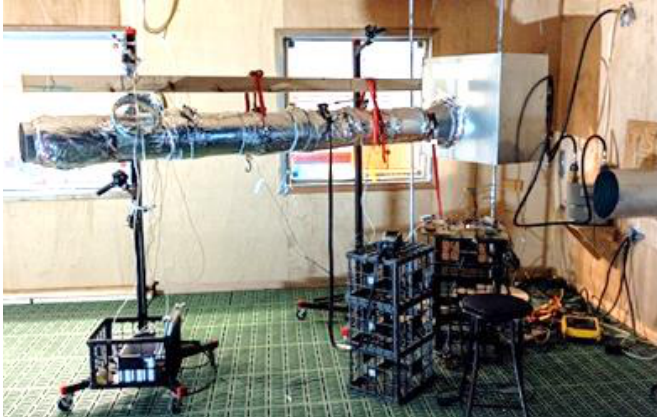
Figure 1. Test duct with locations of temperature measurement taps (D) and velocity pressure pitot tube (E). Measurements for the specific labels are in Table 1. Note diagram is not to scale. Table 2. Dimensions of the test duct in Figure 1.